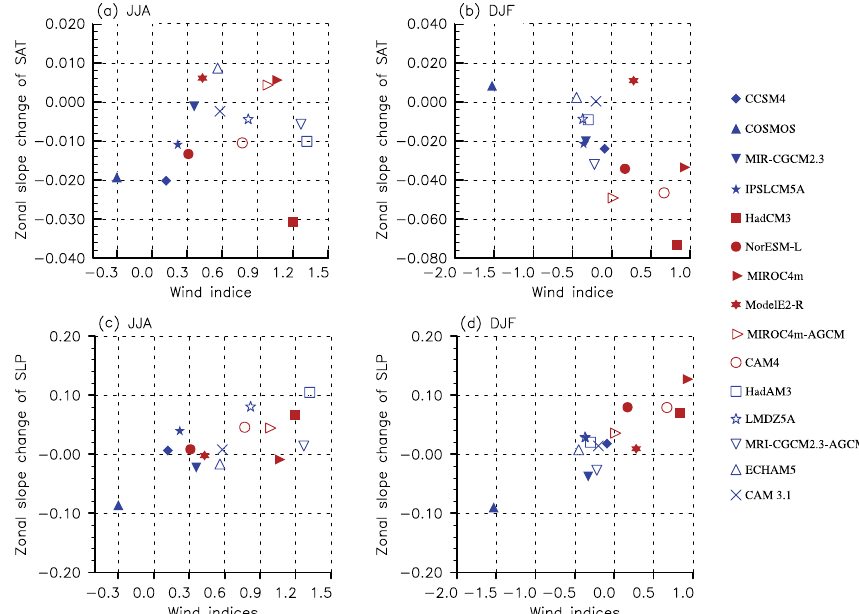
Fig. 10. Changes in zonal SLP and SAT slope averaged within the region of 10–40 ◦ N and 90–180 ◦ E versus changes in wind indices (units: ms − 1 ) . The six models that simulate the weakened EAWW are shown in